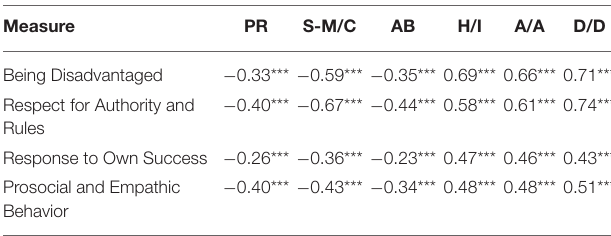
TABLE 5 | Correlations between the problematic situations factors and the SSBS-2 ( n = 169). Measure PR S-M/C